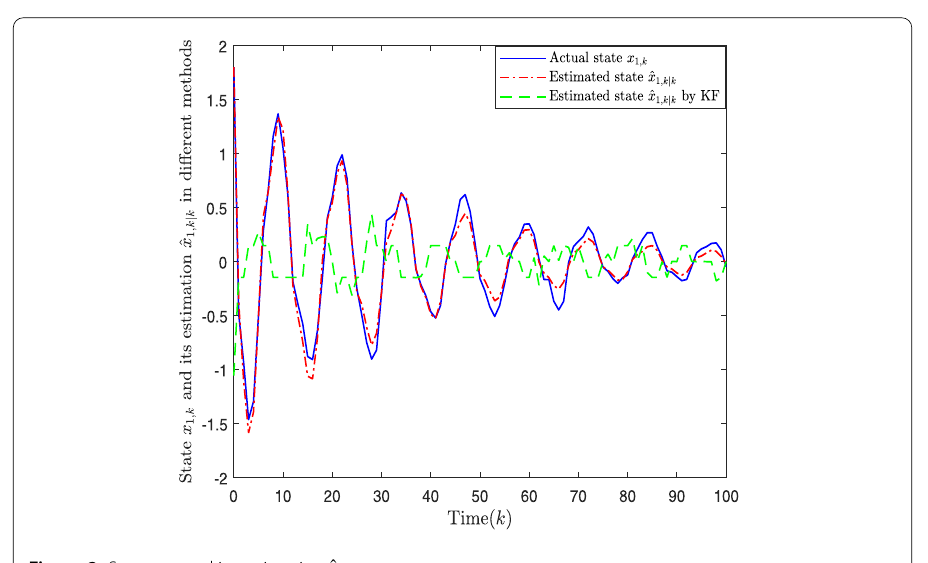
Figure 2 State x 1, k and its estimation ˆ x 1, k |